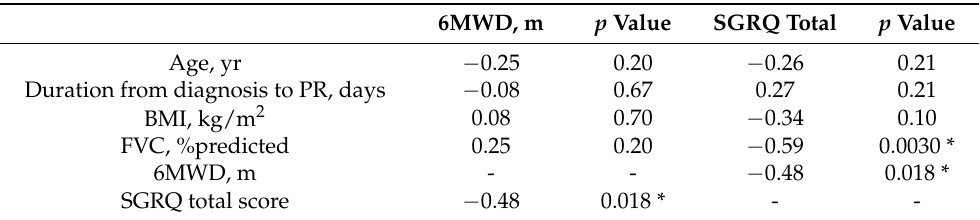
Table 2. Relationship of baseline values with 6MWD and SGRQ total score.